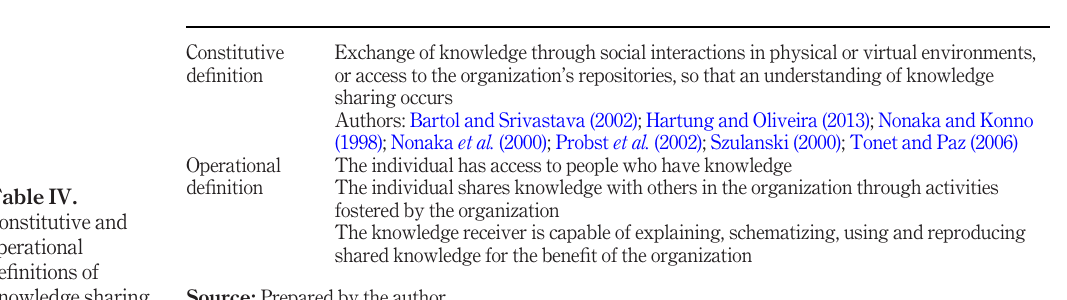
Table IV. Constitutive and operational de fi nitions of knowledge sharing